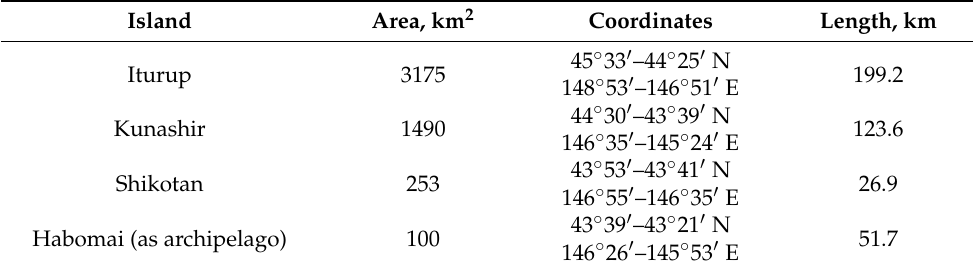
Table 2. The physiographical data on islands under